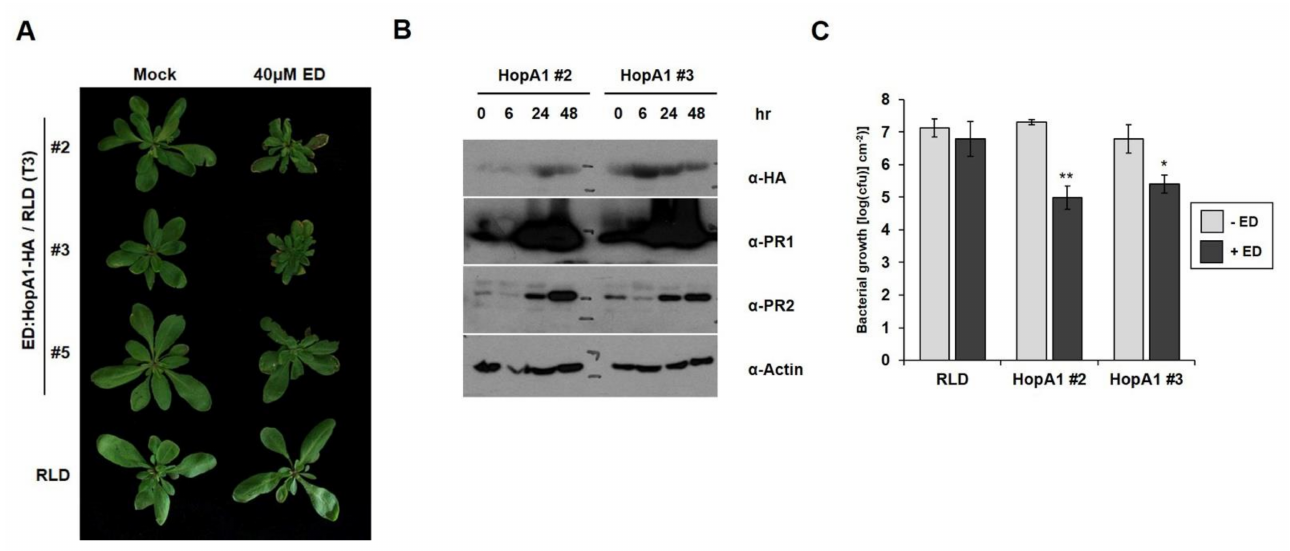
Figure 5. Induction of HopA1 Pss61 triggers defense responses and bacterial growth suppression. ( A ) Estradiol- HopA1 Pss61 transgenic plants were generated in wild-type RLD. Plant phenotype was analyzed 7 days after spraying 40 µ M estradiol (ED) or ethanol (Mock); ( B ) Total proteins were isolated in estradiol- HopA1 Pss61 transgenic plants (line #2 and line #3) at the indicated times after spraying estradiol. Immunoblots were analyzed with the indicated antibodies; ( C ) In planta bacterial growth was measured in indicated plants after inoculation with DC3000 at 10 5 cfu/cm 2 in the absence (gray columns) or presence (black columns) of estradiol. Asterisk indicates significant differences with wild-type RLD (** p < 0.01, * p < 0.05, Student’s t -test). This experiment was repeated twice with a similar